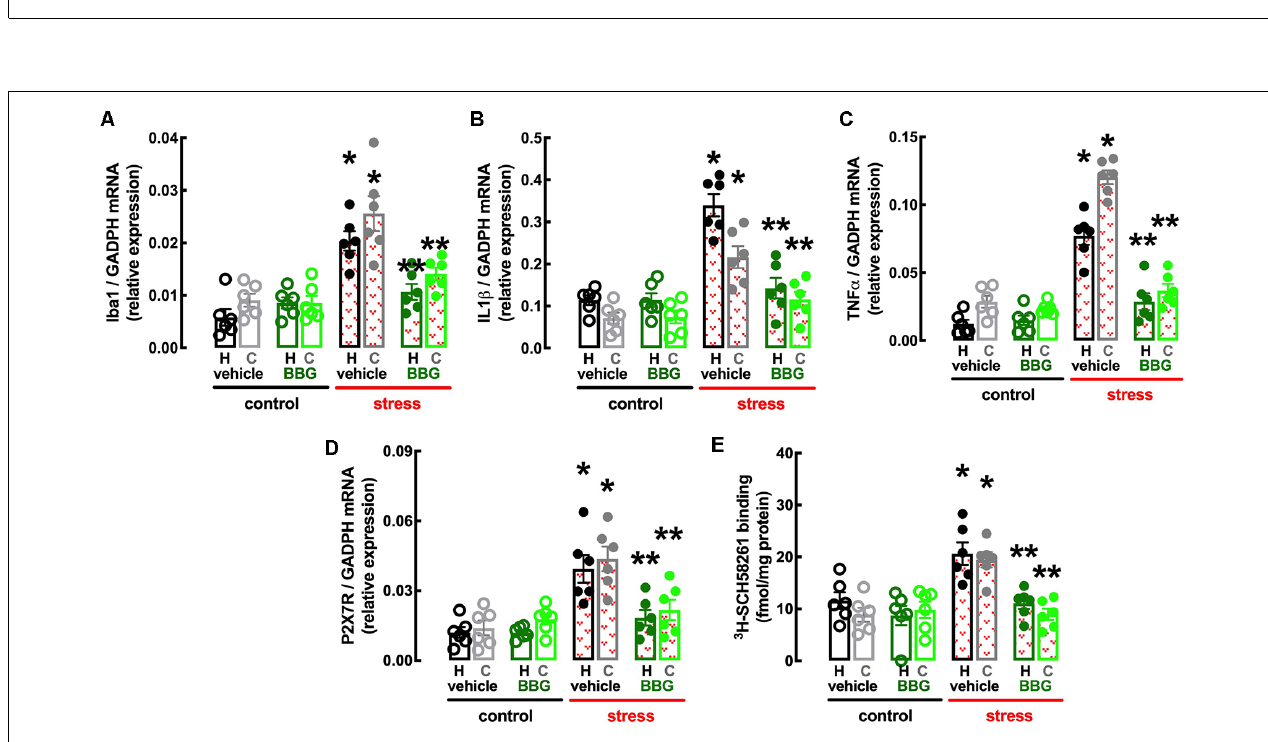
FIGURE 5 | Male adult Wistar rats (8–10 weeks old) subject to a protocol of restraint stress (4 h/day) during 14 days display an increased expression of inflammatory markers and an up-regulation of P 2X7 and A 2A receptors in the hippocampus (black, dark green) and prefrontal cortex (gray, light green) which were prevented by the P 2X7 receptor antagonist Brillant Blue G (BBG). Whereas BBG treatment (45 mg/kg, ip, daily, beginning 3 days before the stress protocol and until the sacrifice of the animals; green) was devoid of effects in non-stressed control rats (open bars), BBG prevented all alterations of stressed rats (red checkered bars), namely the increased expression of the microglia marker Iba1 (A) , of interleukin 1 β (IL1 β ; B ), of tumor necrosis factor α (TNF α ; C ), and P 2X7 receptors (P 2X7 R; D ) as well as an increased density of A 2A receptors (A 2A R; E ) as assessed by the binding density of a supramaximal concentration of the selective A 2A R antagonist 3 H-SCH58261 (2 nM). Data are shown as mean ± SEM; n = 5–7 rats per group. * P < 0.05 vs. control-water, ** P < 0.05 vs. stress-water using a Tukey’s multiple comparisons post hoc test after a two-way ANOVA.